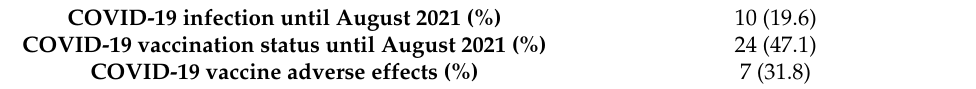
Table 6. Data regarding COVID-19 of the 51 patients included in the study.